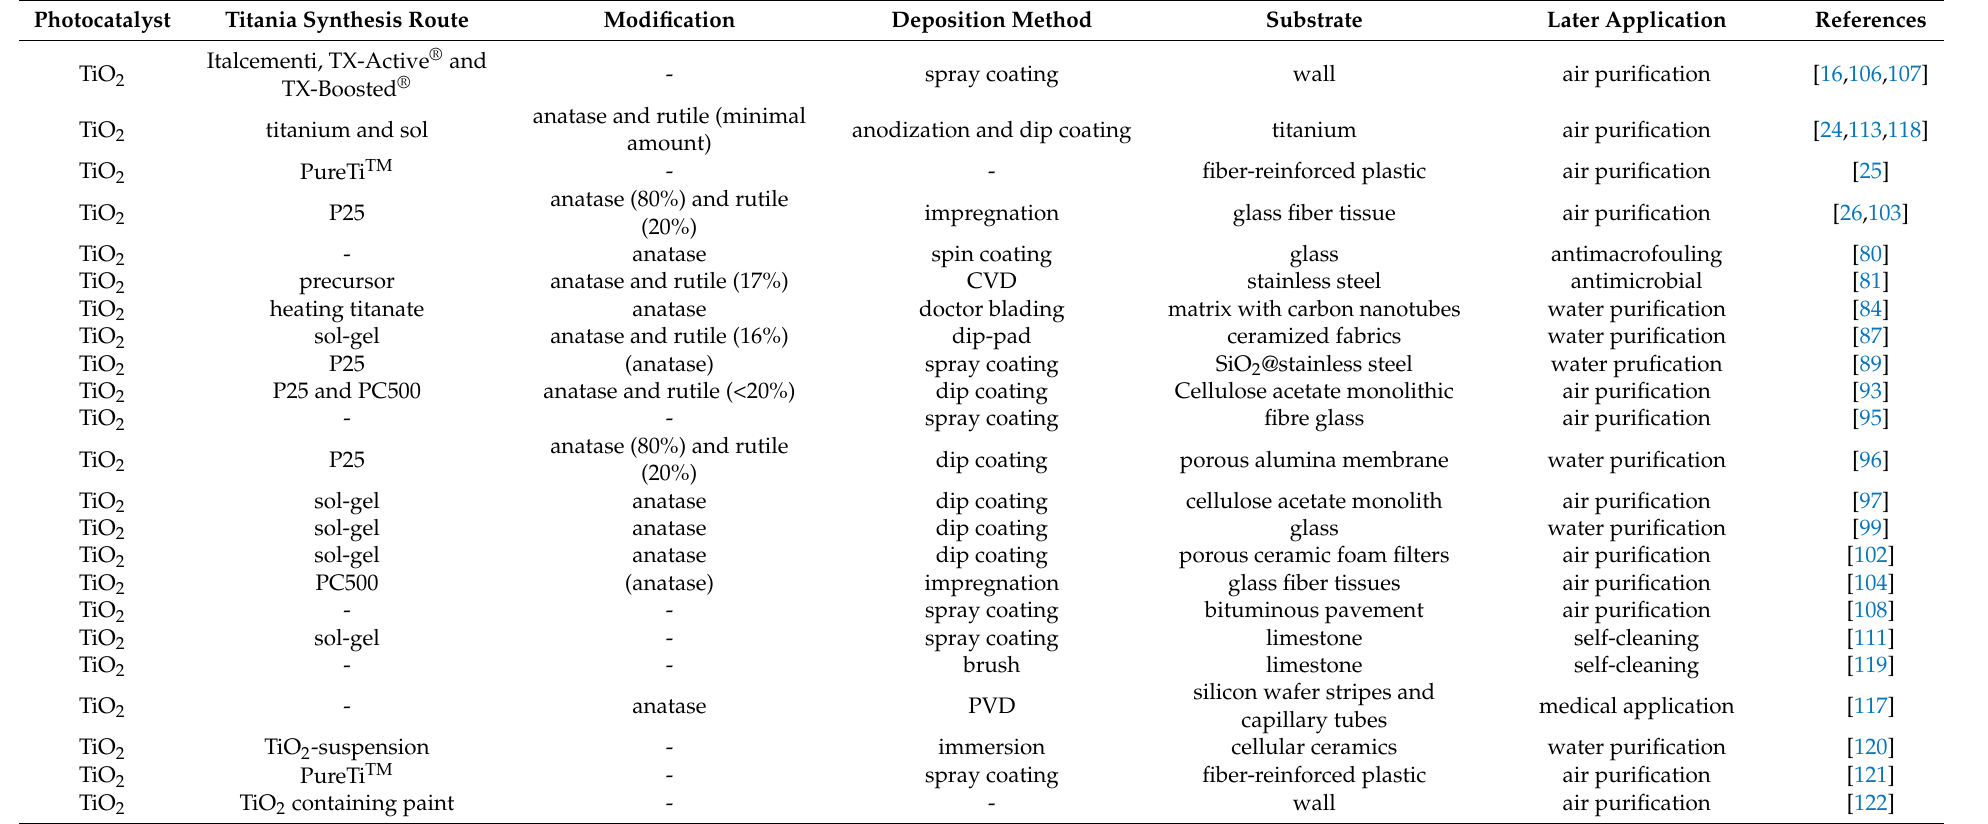
Table 1. Synthesis methods, obtained titania modifications (if known), deposition technique, and anticipated application for undoped TiO 2